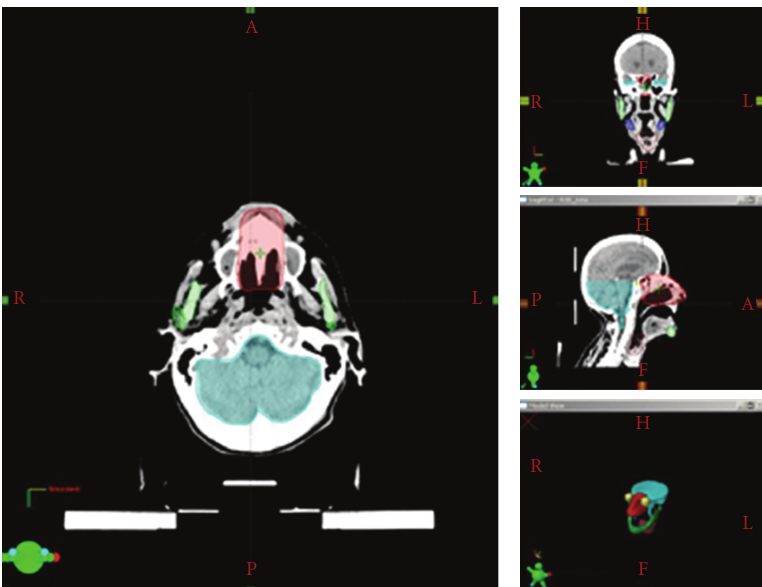
Figure 2: Radiotherapy planning II . Another CT section at the lower PTV boundary. Small insets show the complete extension of the PTV.